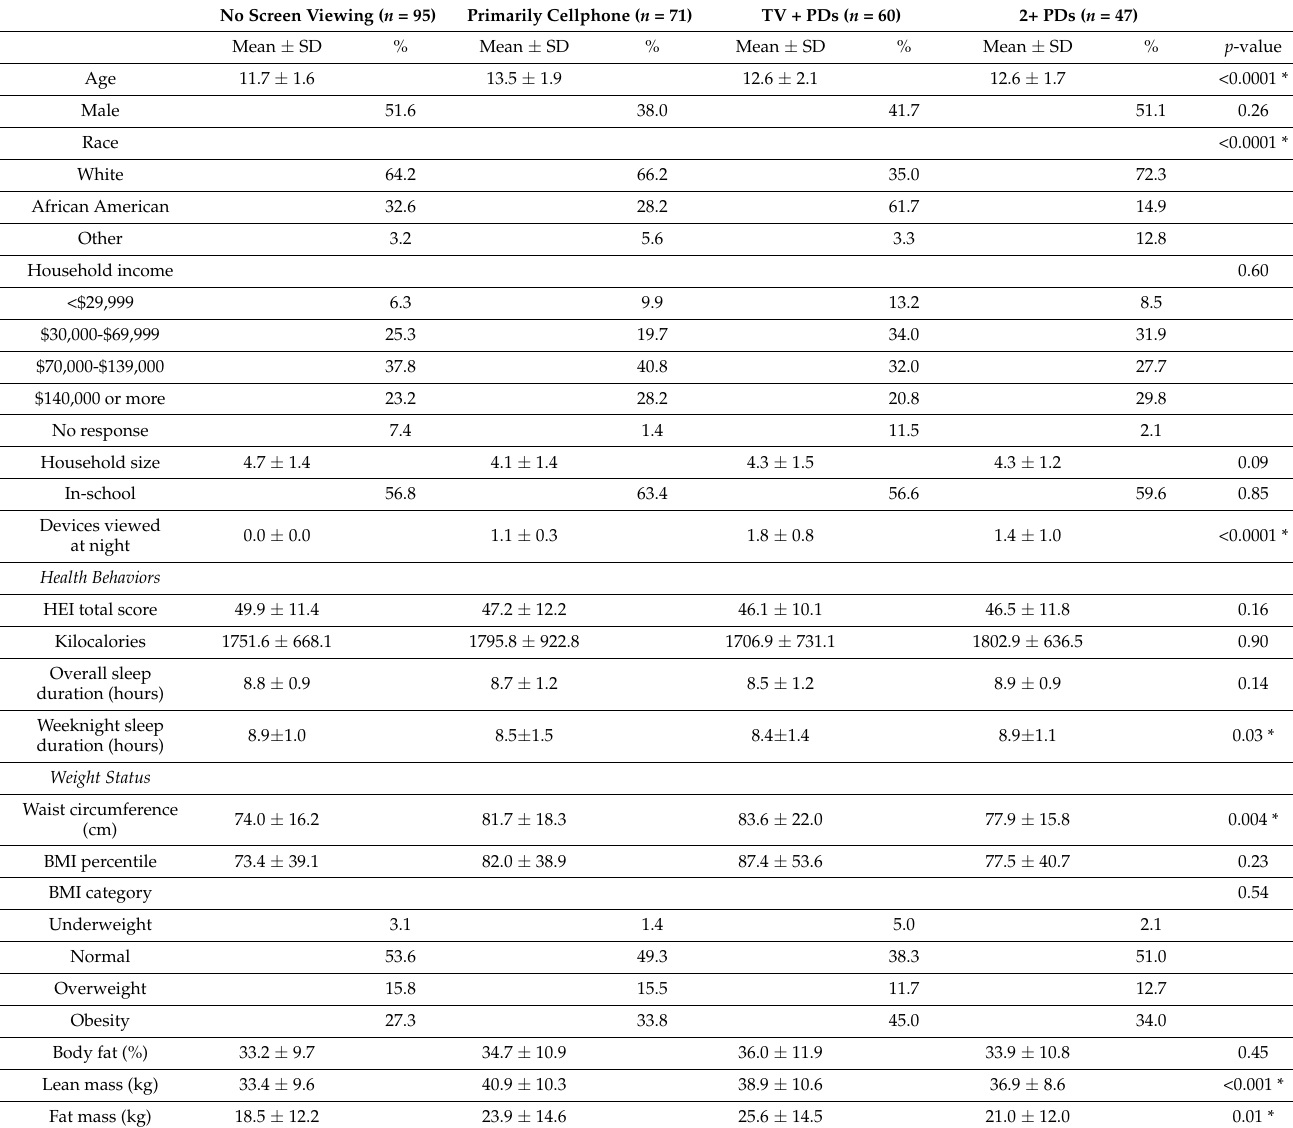
Table 1. Descriptive characteristics of the sample by night-time screen-viewing cluster ( n = 273)